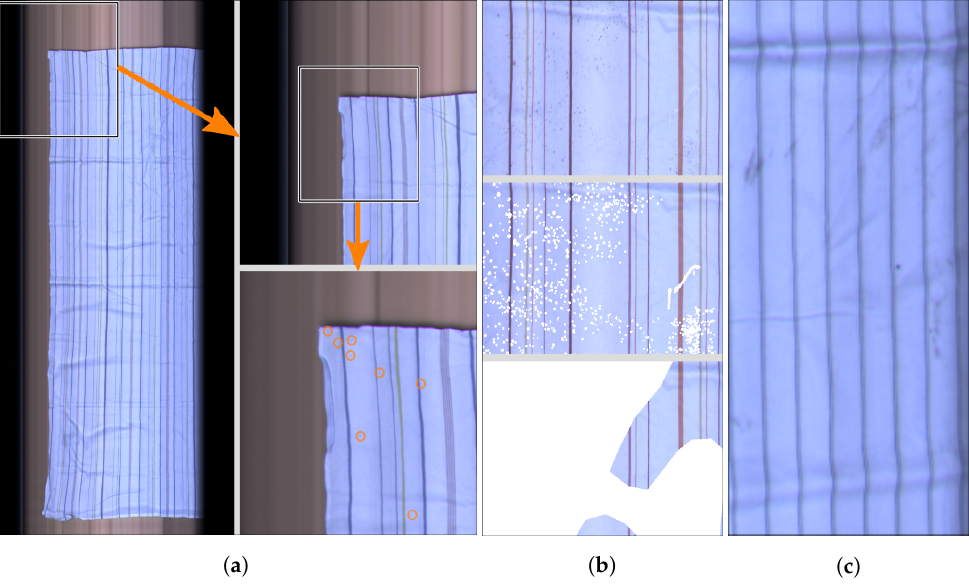
Figure 3. Illustrations of properties that differentiate the collected dataset from others. ( a ) illustrates how large the images are in comparison to the stains/salient regions. ( b ) shows a piece of laundry with a large amount of stains. From top to bottom: the image, a precise annotation, an rough annotation. ( c ) shows examples of blurry